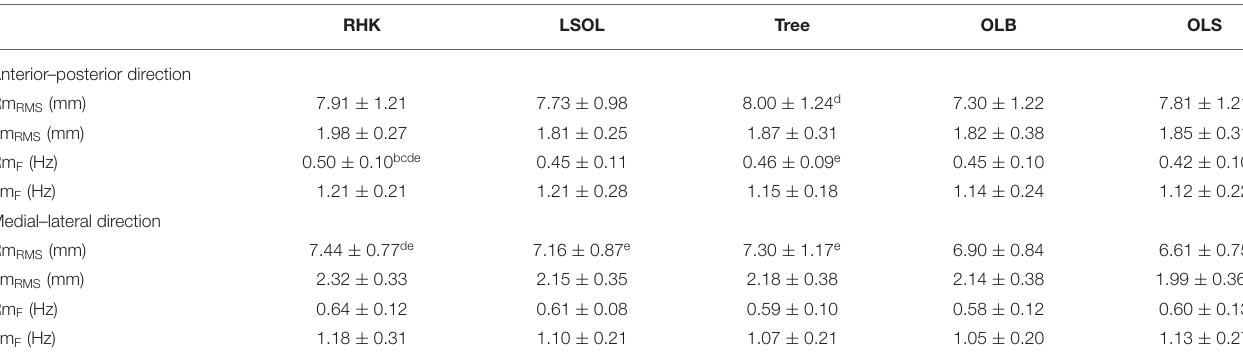
TABLE 1 | Rambling and trembling parameters during one-leg stance postures of Tai Chi and